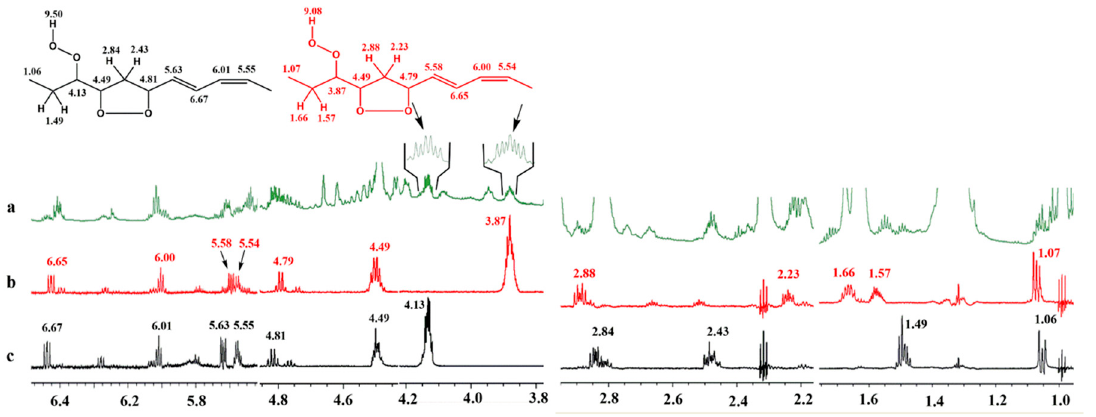
Figure 6. ( a ) 800 MHz 1D 1 H-NMR spectrum of 20 mg of methyl linolenate, subjected to heating at 40 °C for 48 h, in CDCl 3 (T = 298 K, acquisition time = 1.02 s, relaxation delay = 5 s, number of scans = 128, experimental time = 10 min). ( b ) and ( c ) selective 1D TOCSY spectra of the same solution using a mixing time of τ m = 300 ms. The arrows denote the selected resonances of the two diastereomeric 9- cis, 11- trans -16-OOH endo -hydroperoxides that were excited at δ 3.87 ( b ) and δ 4.13 ( c ).